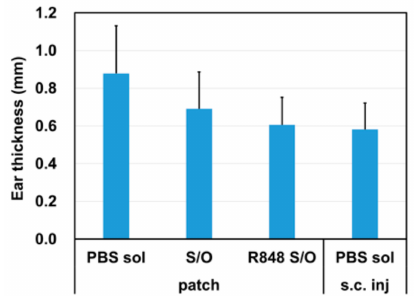
Figure 5. Acute skin reactions. The ear thicknesses of mice treated as described in Figure 3a were measured 5 min after skin contact with whey